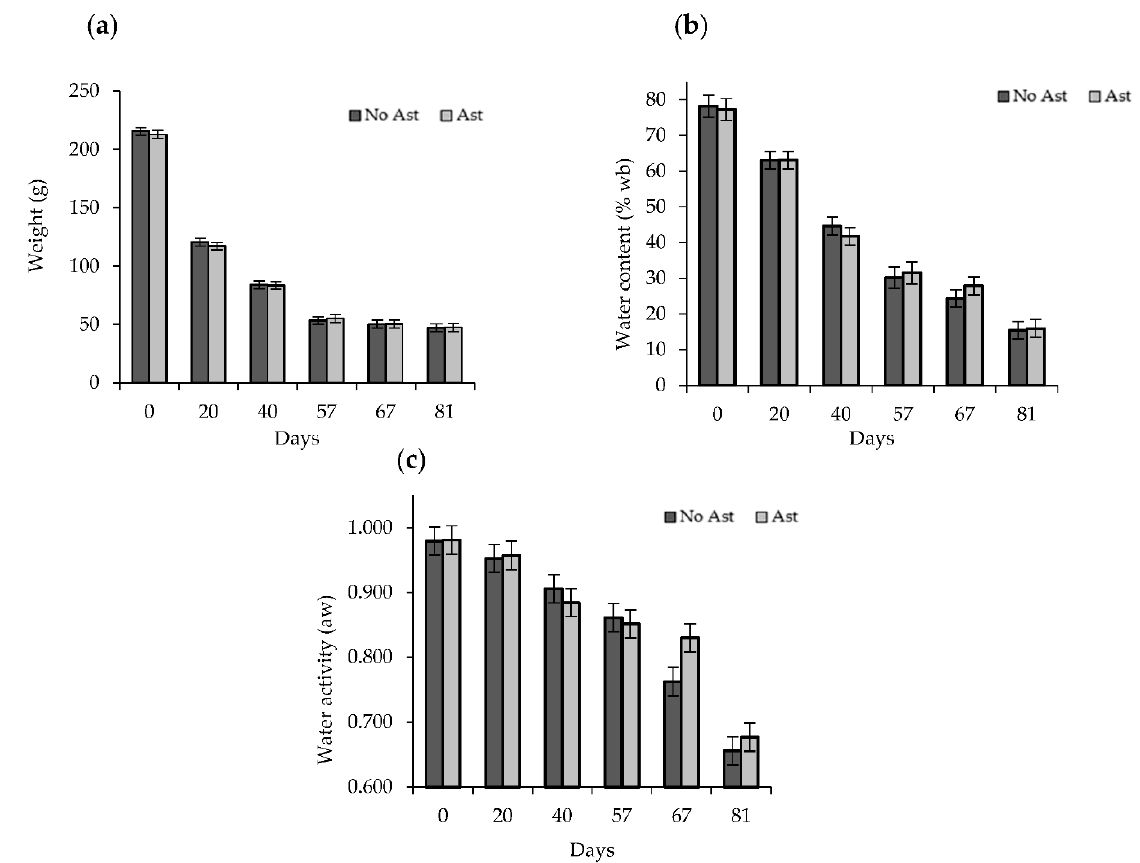
Figure 1. Weight loss ( a ), water content (g/100 g product on a wet basis) ( b ) and water activity ( a w ) ( c ) of the non-astringent (no Ast) and astringent (Ast) persimmon samples during the drying treatment. Bars represent the least significant difference (LSD) intervals ( p ≤ 0.05).